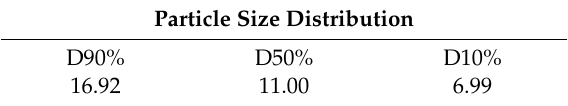
Table 8. Particle size distribution of the resulting residue from chalcopyrite leaching in test P5.